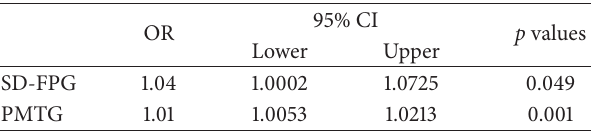
Table 3: Multivariate logistic regression analysis for progression of